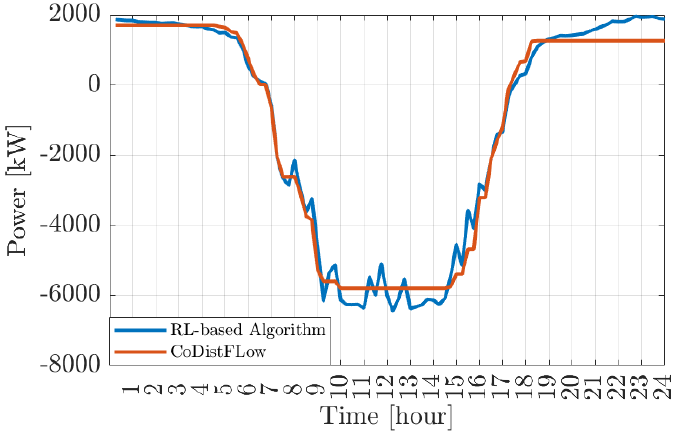
Figure 7. Dispatch plan obtained by Algorithm 2 with 80 scenarios as an input (i.e., in D day